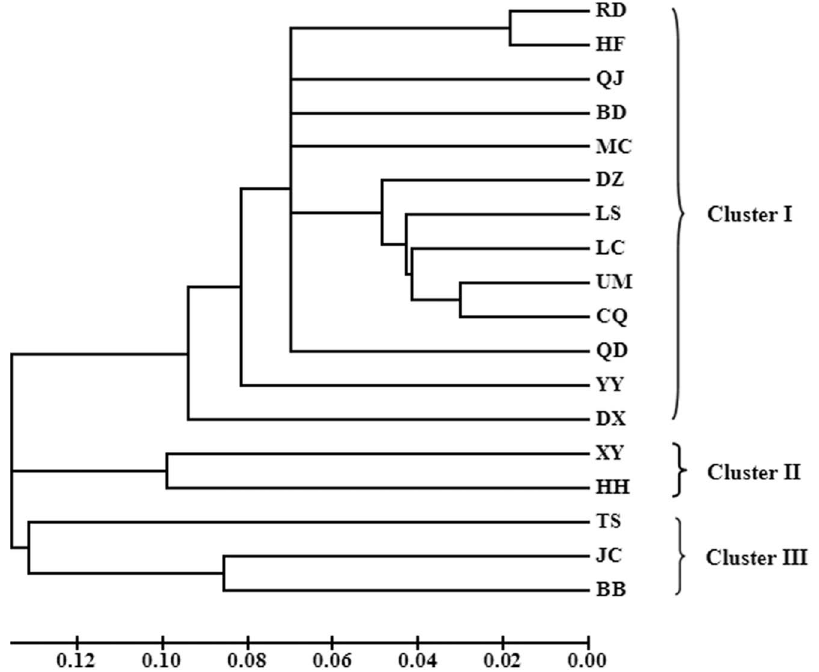
Figure 7. Dendrogram for 18 populations of Callosobruchuschinensis in China based on 20 SSR loci (Population code see table 2). doi:10.1371/journal.pone.0095458.g007 PLOS ONE |